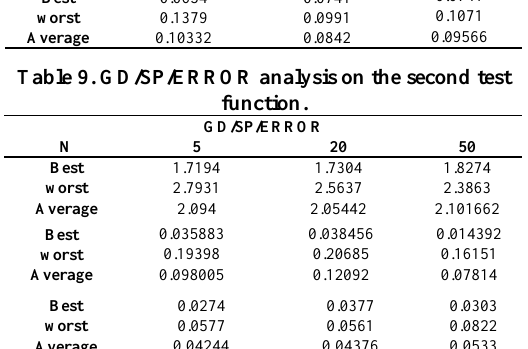
function. GD/SP/ERROR